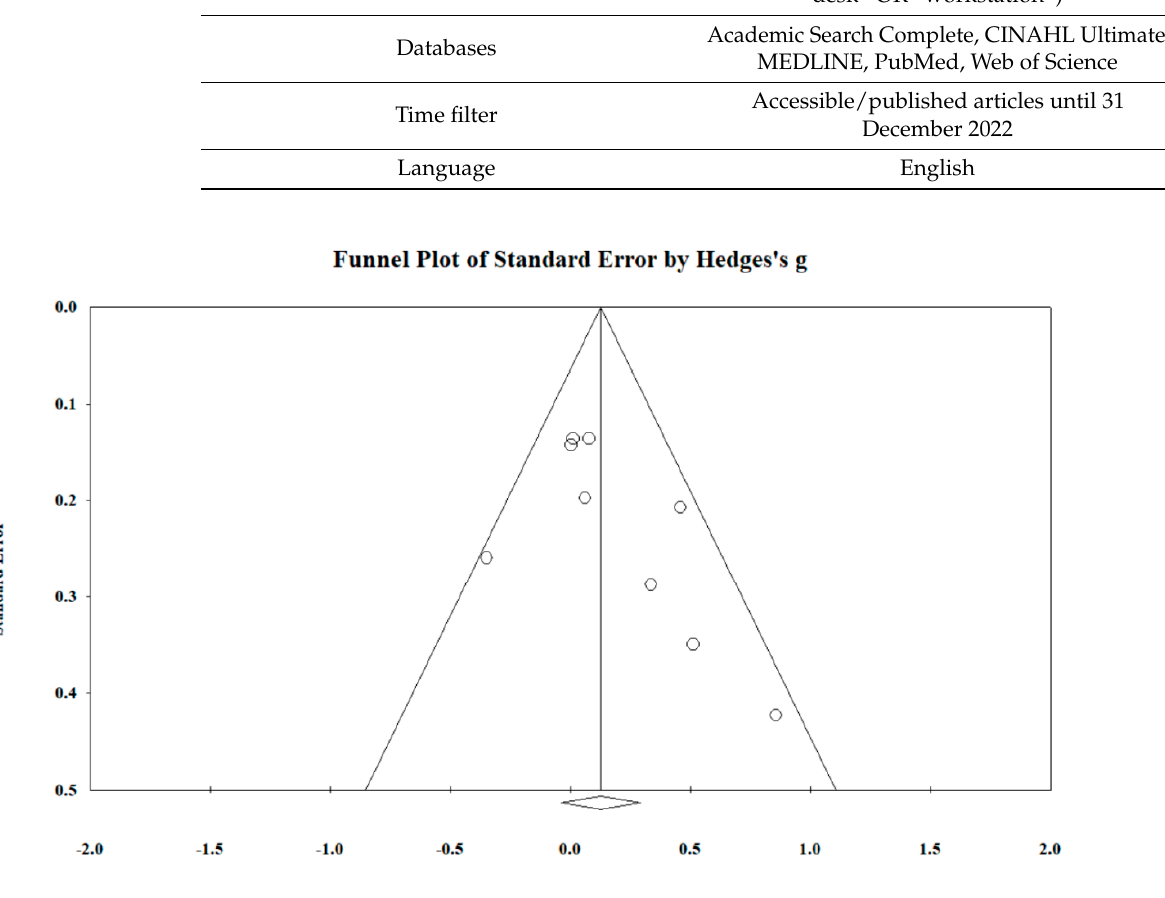
Figure A2. Funnel plot of Hedges’ g vs standard error for congruent stimuli.